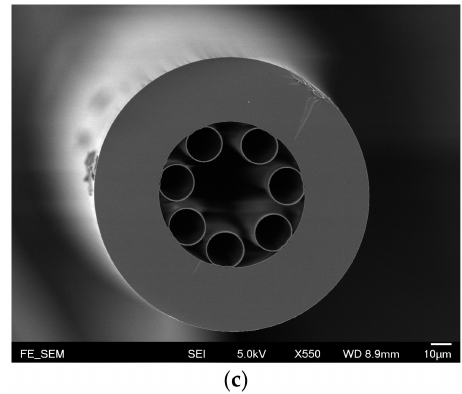
Figure 2. ( a ) Absorption lines of oxygen from 759.5 to 762 nm at 293 K and 1 atm determined by the HITRAN database. ( b ) Spectral transmission of the HC-NCF. ( c ) The cross-sectional image of the